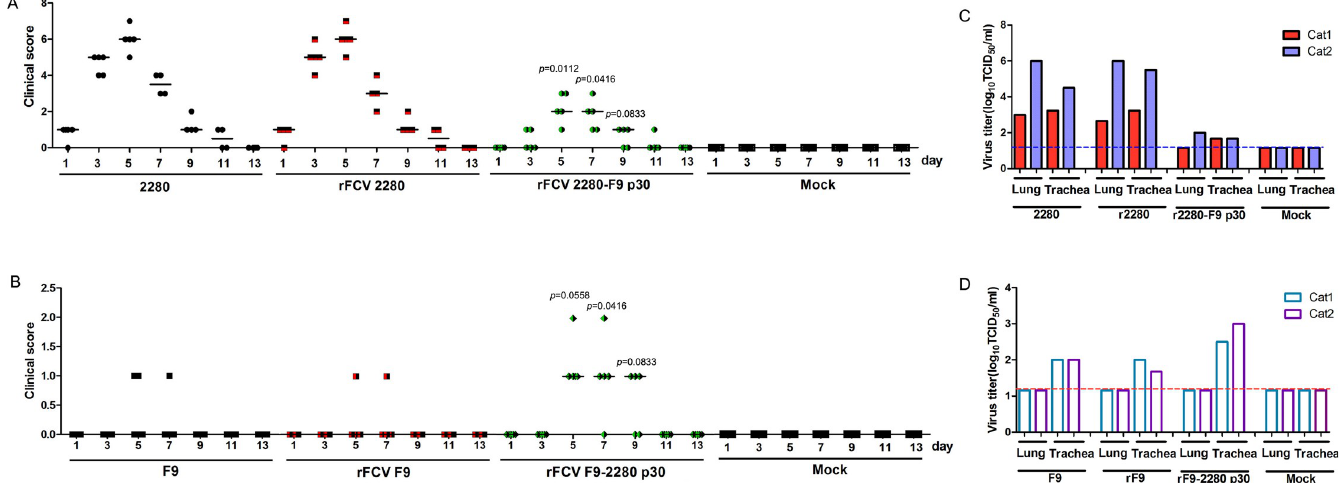
Fig 9. Examination of clinical symptoms and virus titres in tissues during infection. (A, B) After infection, the clinical signs were monitored daily and scored according to Table 2. Each score for each animal and the median were shown. Differences (Mann-Whitney U test, p < 0.05 as a significant difference) between the experimental and control groups are noted. (C, D) On day 5 post-infection, two cats from each group were euthanized and lung and trachea were harvested to assess the virus titre. Each lung lobe (1 g) was collected and mixed, then homogenized together. The horizontal dashed lines indicate the lower limit of detection.